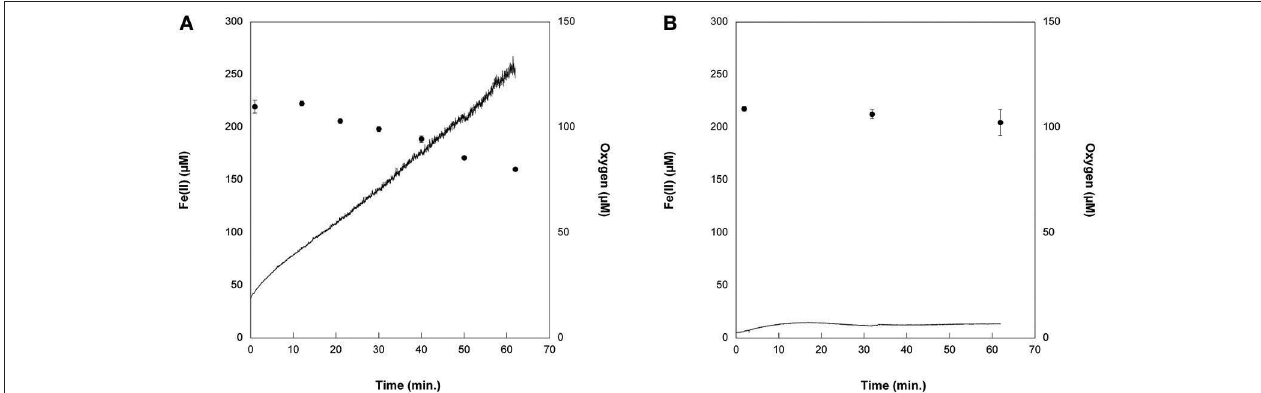
FIGURE 7 | Cell suspensions experiments with Synechococcus PCC 7002 (A) without DCMU, where Fe(II) (circles) was progressively oxidized as oxygen (solid line) was generated by photosynthesis, and (B) when DCMU was added. In the presence of DCMU, oxygen introduced to the cell stand during sampling can account for the minor amount of Fe(II) oxidation